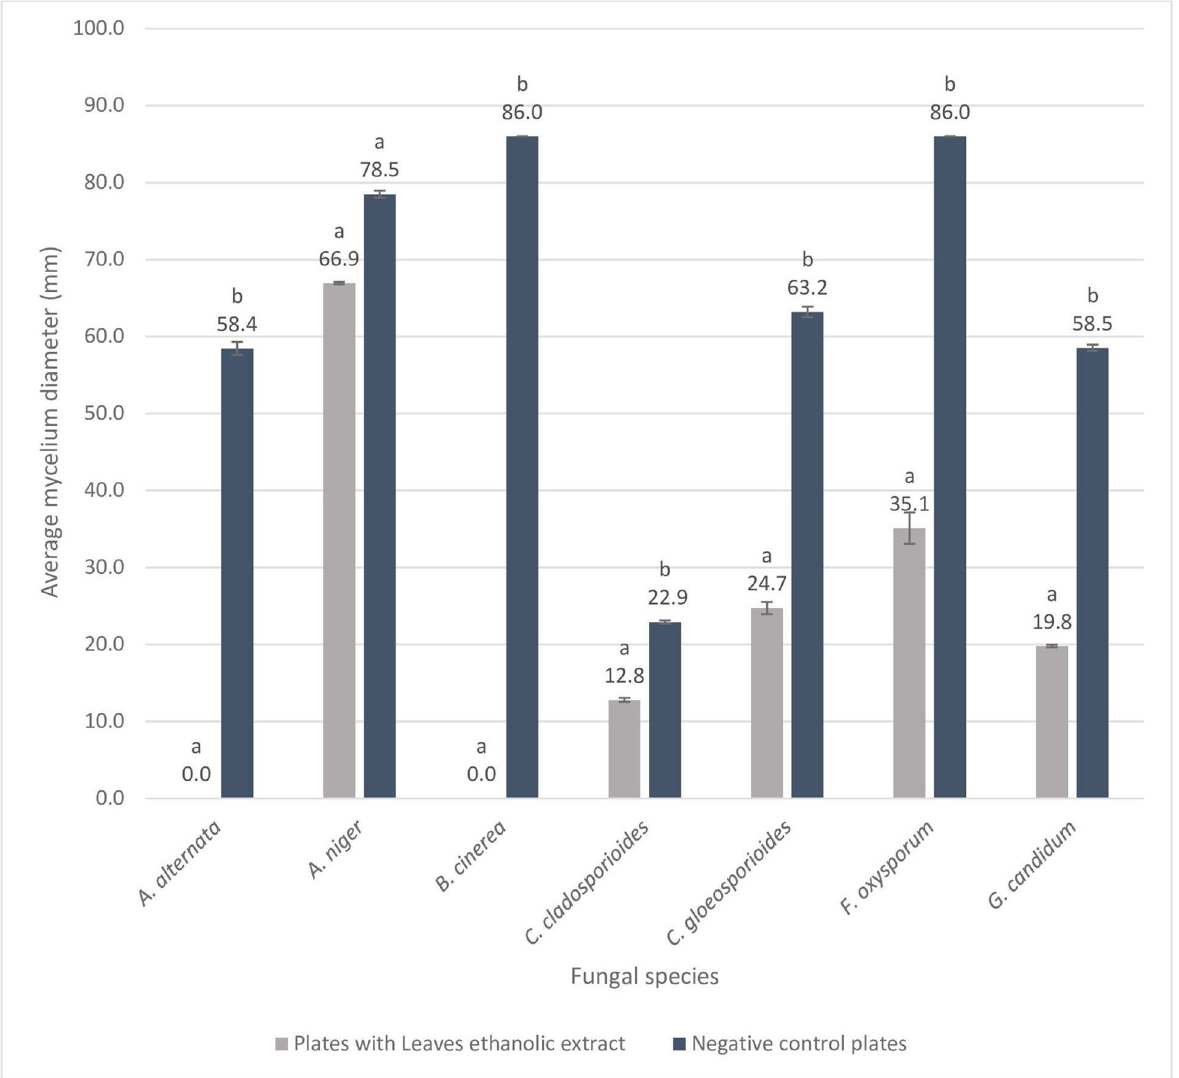
Figure 2. Average mycelium diameter (mm) ± SE (N = 4) of seven fungal species in the presence and absence of PJ-WS-LE extract after 5 days incubation at 25 °C. ab Treatment columns with different letters have their values significantly different as shown by t-test for data of fungal